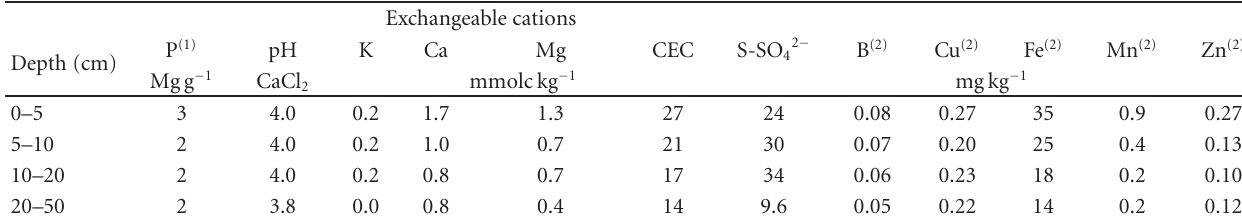
Table 1: Soil analysis of the experimental area before planting.